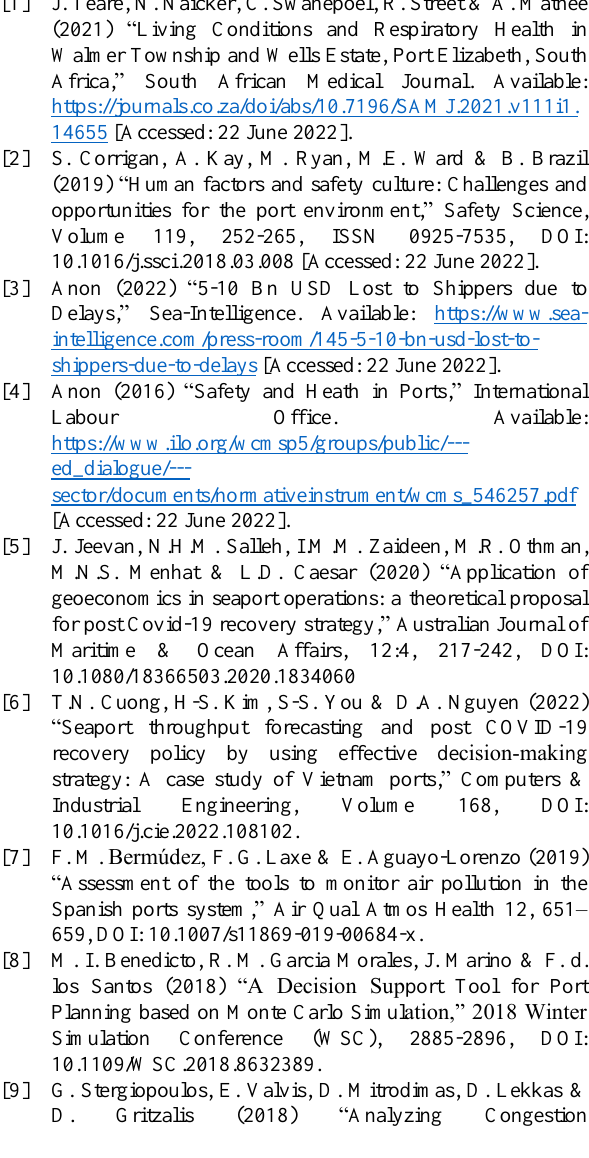
Figure 4. SLA Footprint in the Online Port